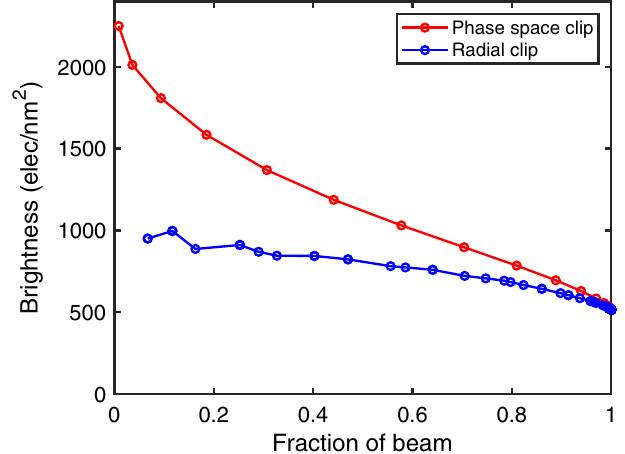
FIG. 9. Measured four-dimensional brightness of a beam with a total charge of 15 fC on the aperture as a function of the fraction of bunch charge included. In blue, we restrict charge with a circular spatial aperture of varying size. In red, we restrict charge with a shrinking phase space ellipse aligned to the beam ’ s transverse phase space distribution which would not be possible to achieve with a single physical